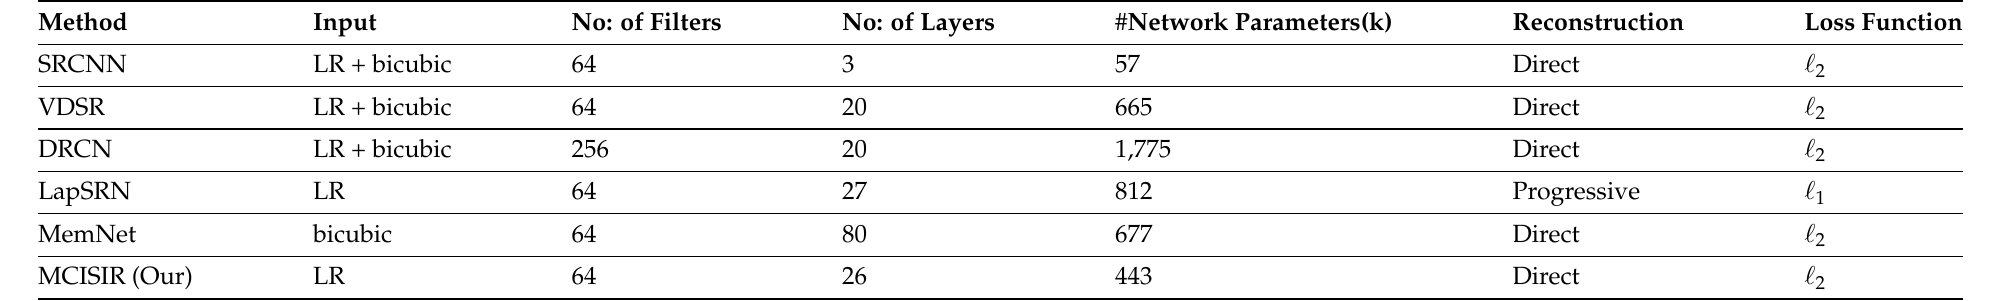
Table 2. Comparison of existing well-known image super-resolution methods in terms of network parameters, number of layers (depth), number of filters, and type of loss